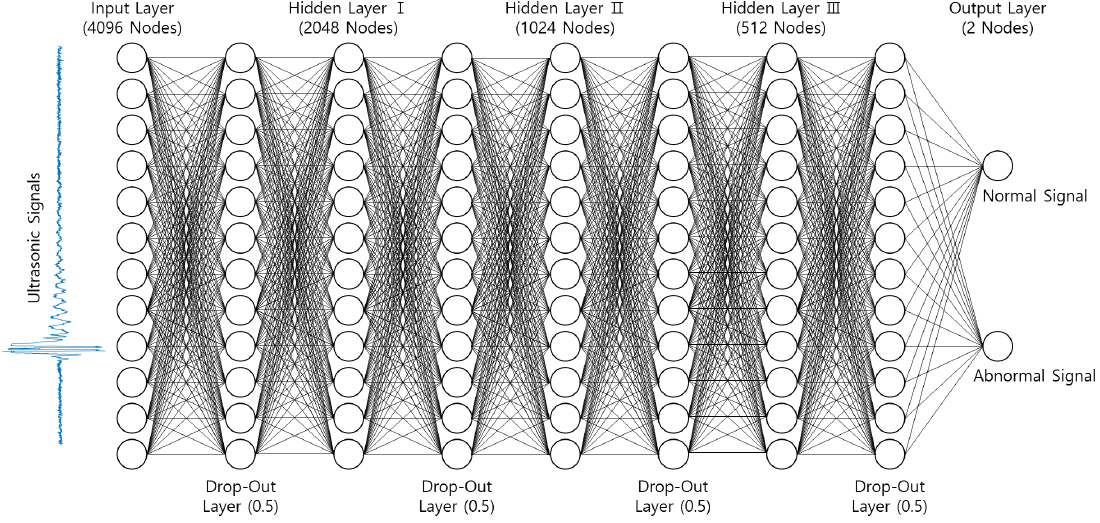
Figure 7. Architecture of the fully connected deep neural network.